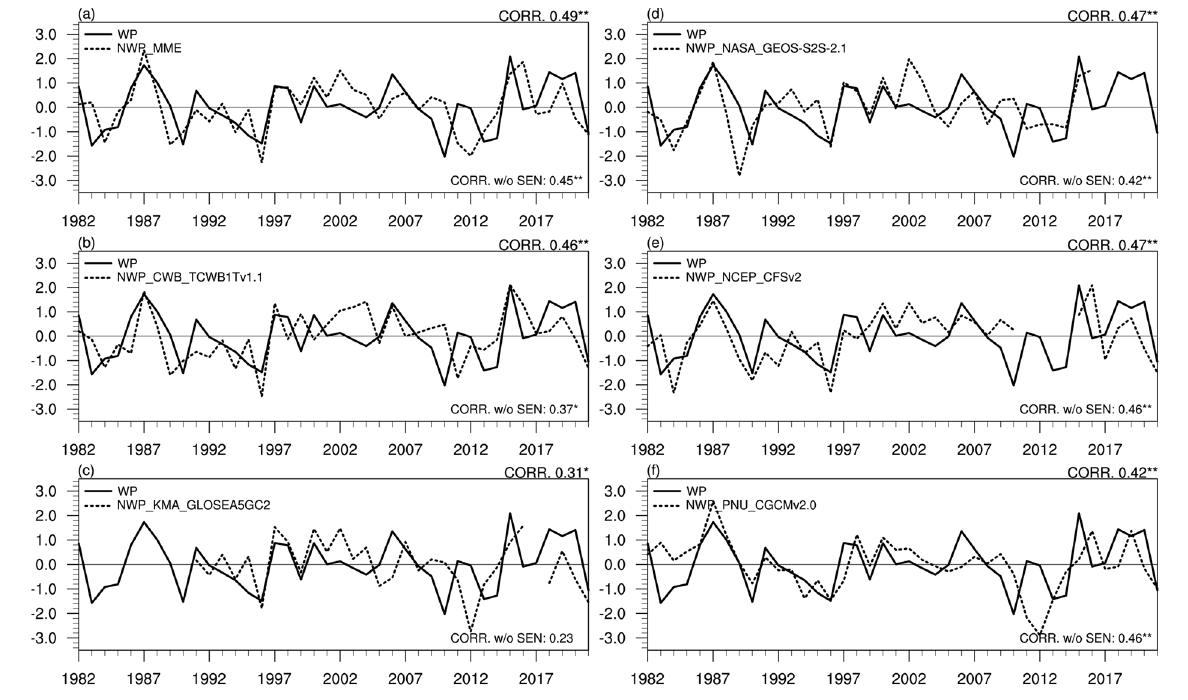
Figure 12. Time series of the WP index (solid line) and the NWP index (dashed line) predicted by ( a ) MME and ( b – f ) individual models. The TCC for the entire series (series without SEN years) is